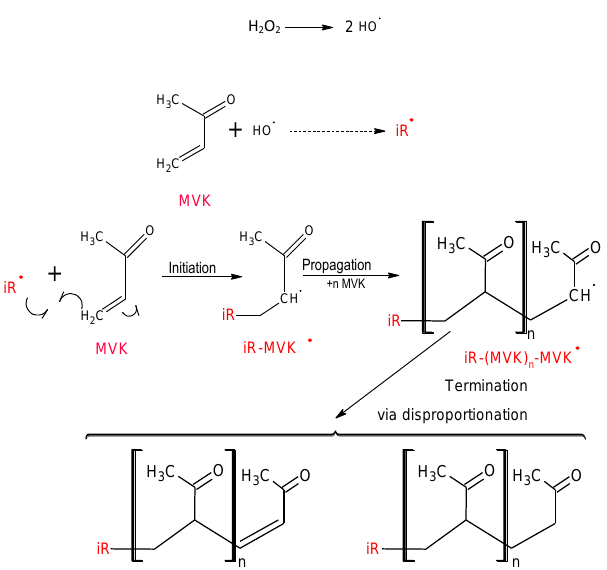
Fig. 6. Scheme of the proposed mechanism of radical oligomerization of MVK in the aqueous phase, initiated by OH-oxidation. iR • is an initiator Radical; MVK is the monomer or the repeating unit, n is the degree of polymerization. For clarity, only the external radical additions are shown.